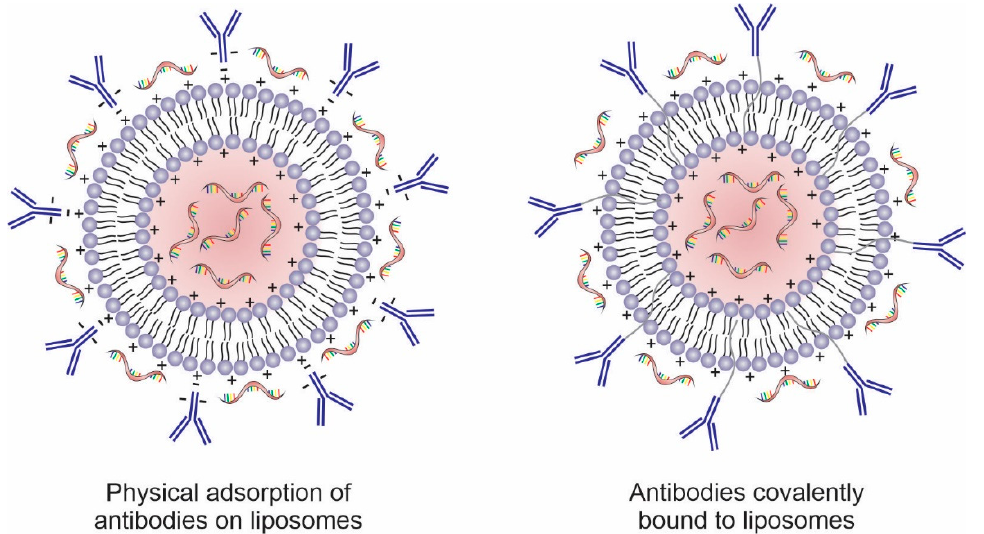
Figure 4. Schematic representation of antibodies physically adsorbed and covalently conjugated to the surface of nucleic acids-loaded liposomes.